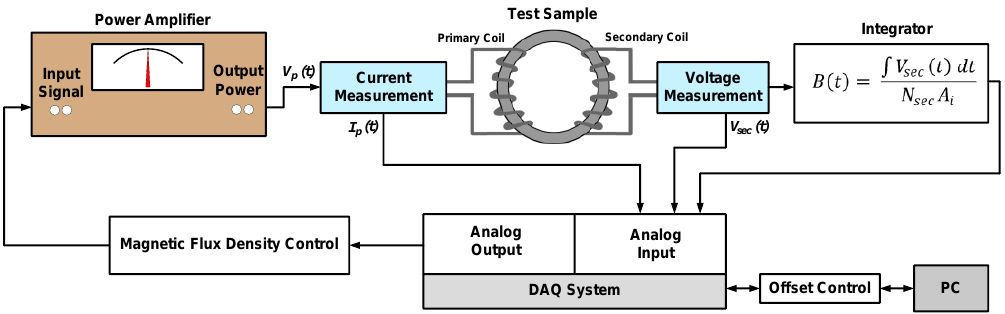
Figure 1. Magnetic measurement schematic of a double coil magnetic circuit.